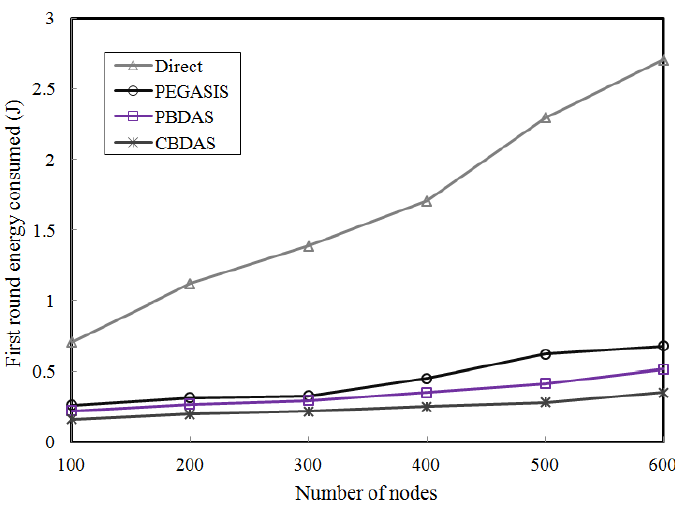
Figure 9. The first round energy consumed.